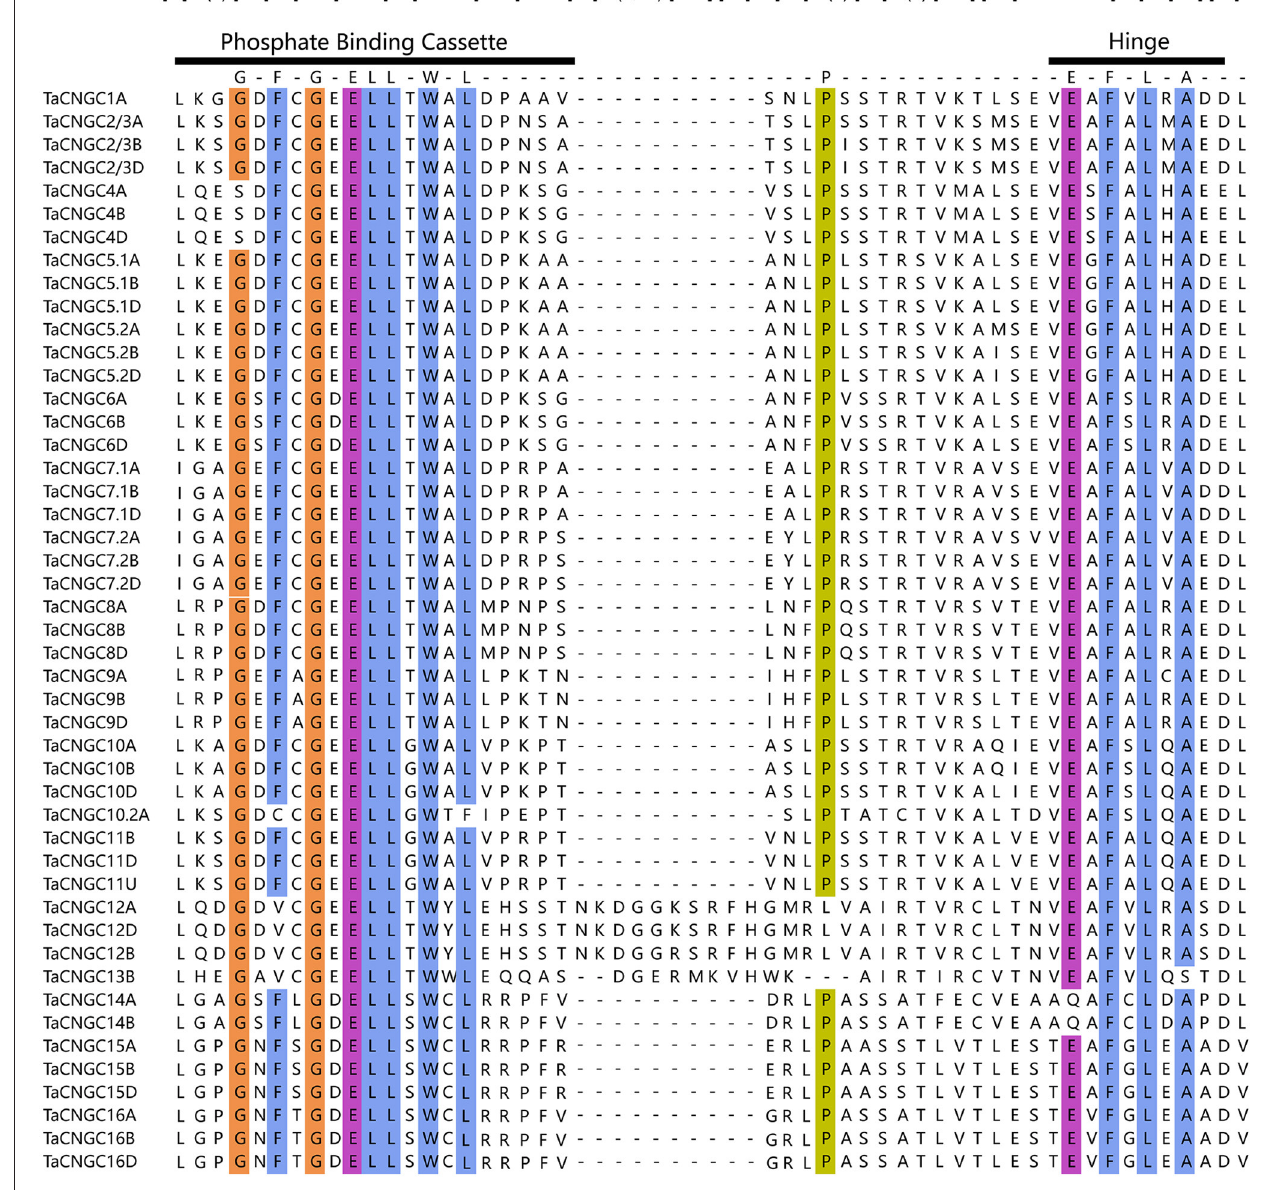
FIGURE 2 | The PBC and the hinge motif within the CNBD of all the TaCNGCs. The wheat CNGC-specific motifs are shown at top. “[]” indicate the various possible of amino acids, “X” could be any amino acid, and “()” represents the number of amino acids. Conserved residues ( > 90%) were in colorful highlighted among all TaCNGCs, and performed by Ugene